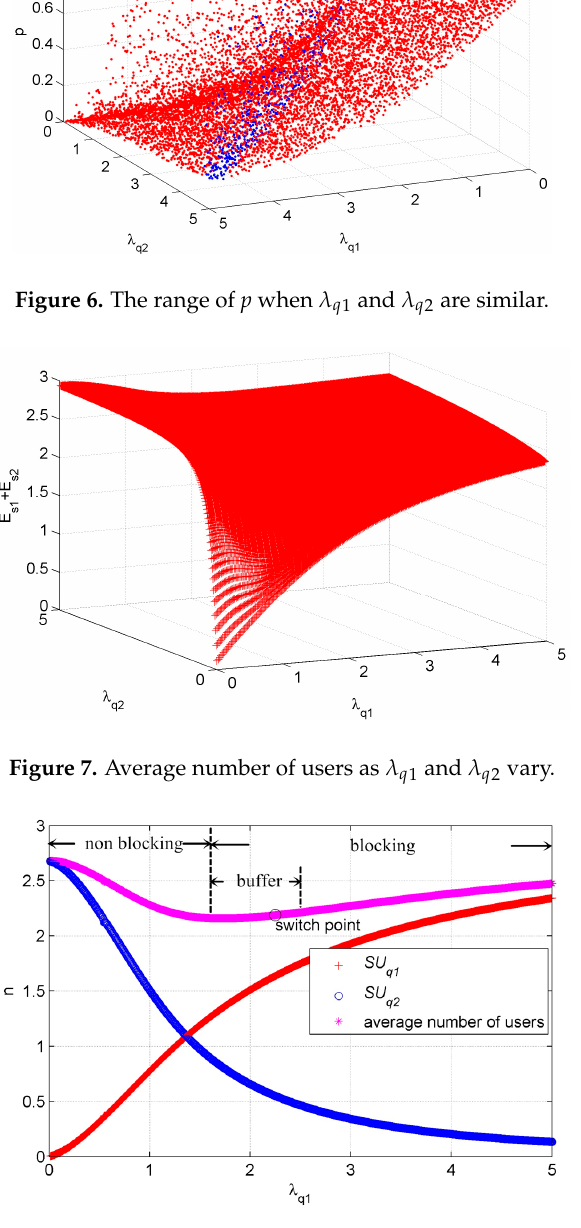
Figure 8. Average numbers of SU q 1 , SU q 2 , and total users.